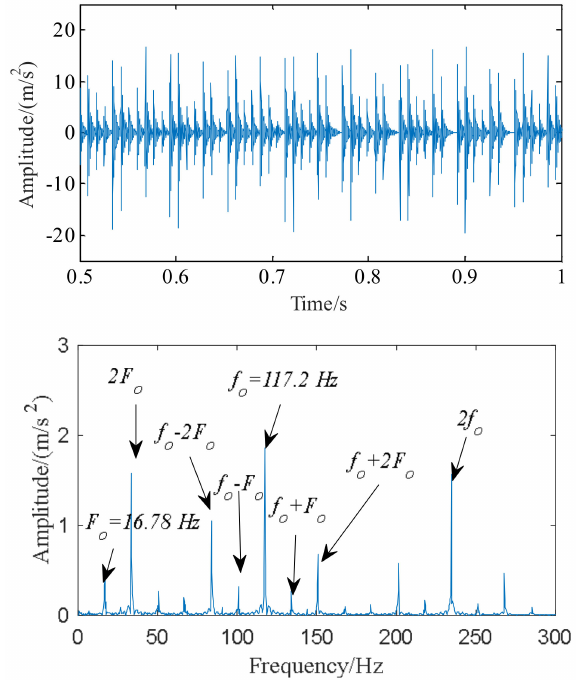
Figure 21. Time–domain waveform and spectrum of the OR fault signal (0.3 mm